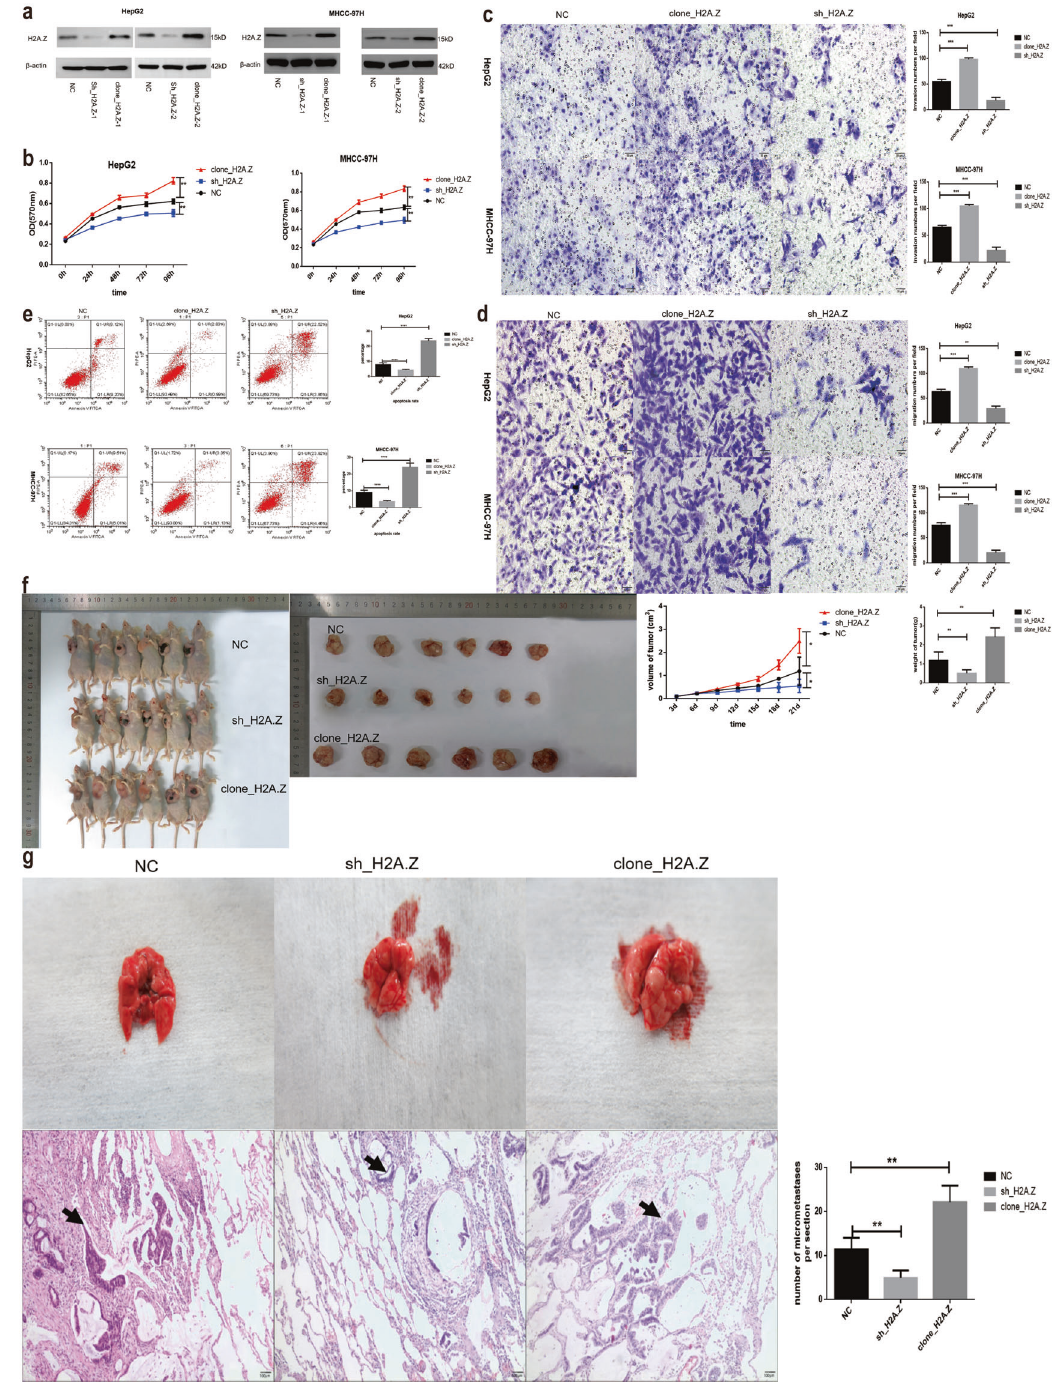
Fig. 2 Effect of H2A.Z on cell growth. a Identi fi cation of the H2A.Z transfection effect detected by western blot. b The proliferation capability of cells was detected by MTT assays. c , d Transwell assay was adopted to test cell migration and invasion under different contexts(Scale bars: 50 μ m). e Flow cytometry was utilized to test the apoptotic cells. f A subcutaneous tumor model in nude mice was used to test the tumor- forming ability of cell lines with different treatments. g A mouse lung metastasis model was used to detect cell metastasis under different contexts (The black arrow marks the metastases) (Scale bars: 100 μ m). The data are expressed in terms of mean ± SD (Student ’ s t -test used in Fig b – g ; * P < 0.05; ** P < 0.01; *** P < 0.001. **** P < 0.0001; n = 3 in each group). transfected in HEK293T cells along with the H2A.Z overexpression exploring. First, we identi fi ed the domain hits of BCL6 on the vector. Finally, Co-IP experiments revealed H2A.Z to mainly bind to protein website: https://www.uniprot.org/, including mainly BTB, the BTB and PHA03247 domains of BCL6 protein (Fig. 4H). Further, four-segment znfH2C2, and PHA03247 (Fig. 4G). Subsequently, the silencing of BCL6 in HCC cell lines decreased the invasion and coding sequences for the three amino acid sequences, labeled migration abilities of tumor cells (Fig. 4I – J). with eGFP, were inserted into the pcDNA3.1 plasmid and co- Cell Death and Disease (2021)